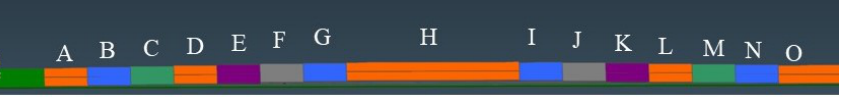
Figure 11. Simulation environment for uneven terrain (Case 1): The heights of all the obstacles used here are summarized in Table